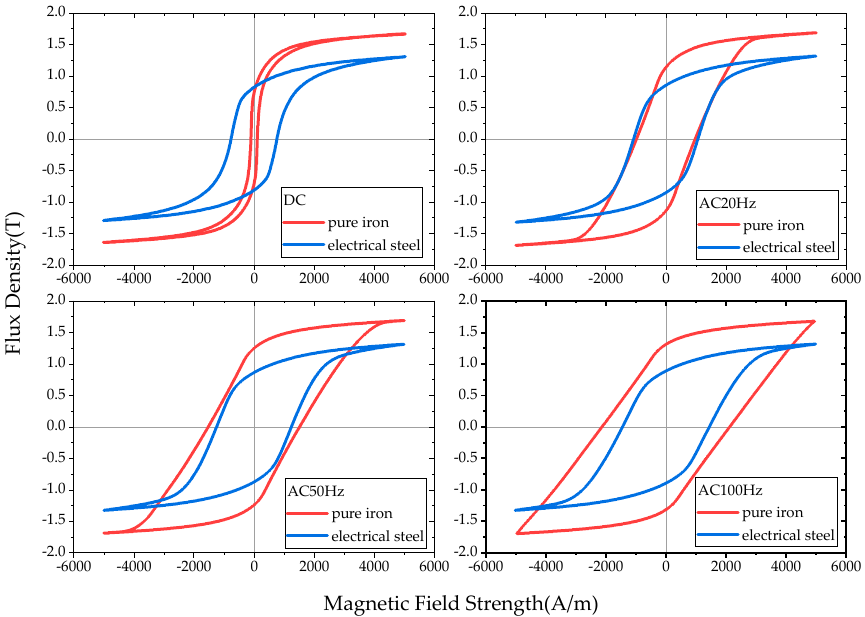
Figure 15. Magnetic Hysteresis Loops of pure iron and electrical steel in DC-magnetic field and AC-magnetic field of 20 Hz,50 Hz and 100 Hz.